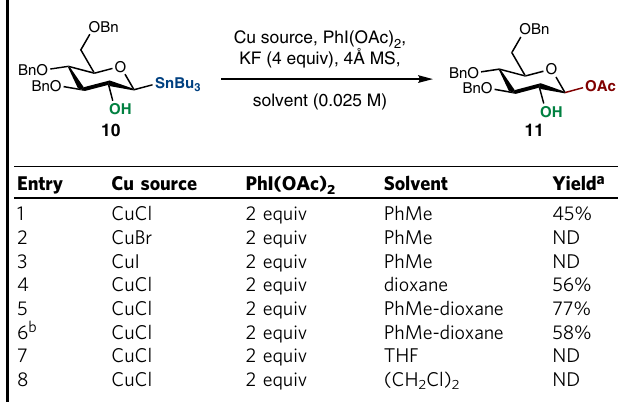
Table 1 Identi fi cation and optimization of anomeric acylation